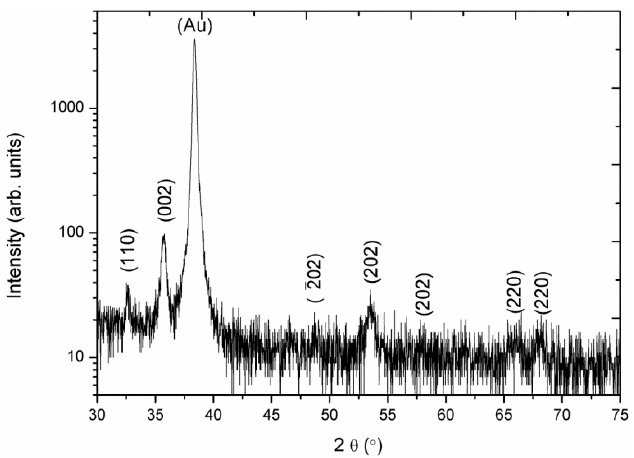
Figure 1. The XRD pattern of CuO nanosheets.